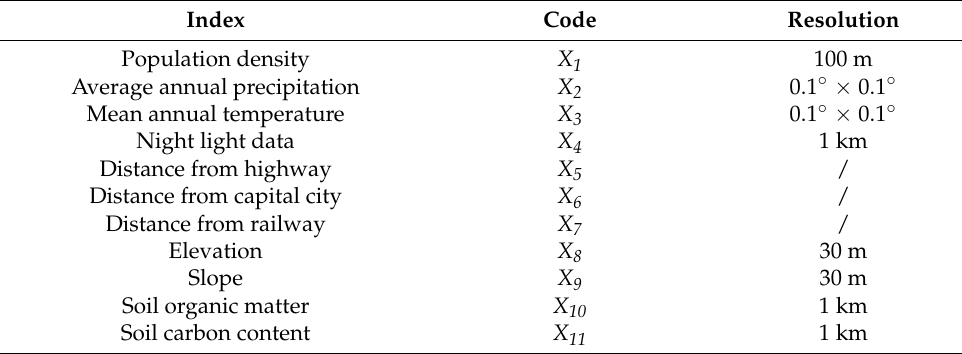
Table 2. Representative indicators of